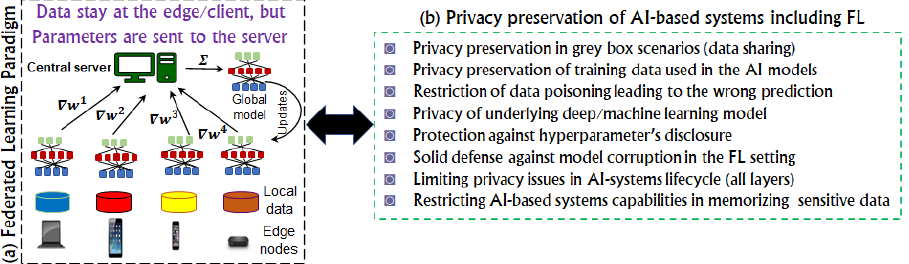
Figure 19. Overview of FL and privacy issues in the context of AI